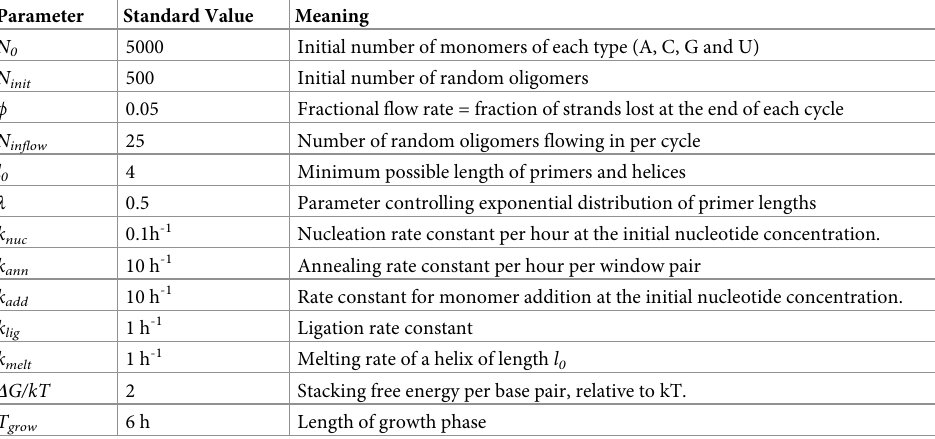
Table 2. Standard values of the parameters used in the simulations.